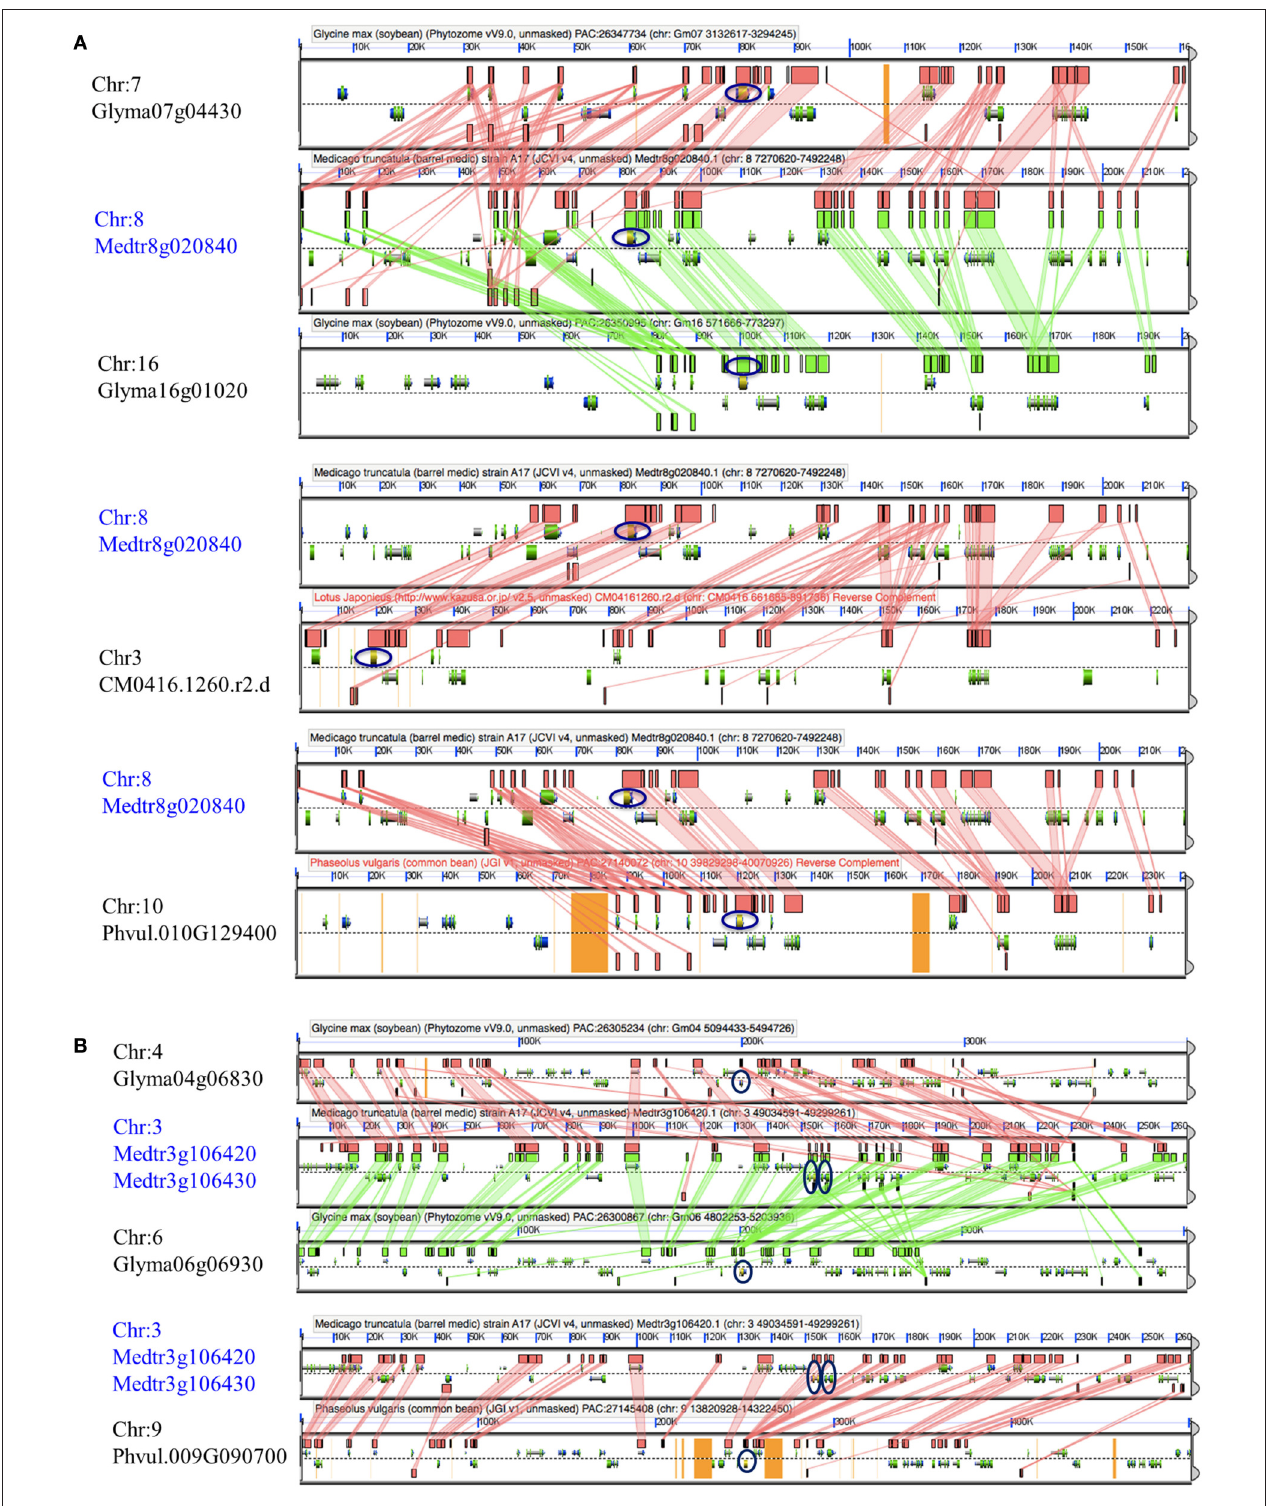
FIGURE 1 | Syntenic relationships between Mt NSP1 (A) and Mt FLOT2/4 (B) loci and chromosome regions from Glycine max , Medicago truncatula , Lotus japonicas, and Phaseolus vulgaris . Each panel is a visualization of chromosome region showing the gene models on positive and negative strands. Green and red blocks in each panel highlight microsyntenic regions between legumes based on gene function and orientation. Genes highlighted in blue (e.g., Medtr8g020840 and Medtr3g106420/Medtr3g106430 for NSP1 and FLOT2/4 genes, respectively) were used as query when performing microsynteny analysis against the four legume species. The NSP1 and FLOT2/4 orthologs based on their microsyntenic relationships are highlighted with blue circles.